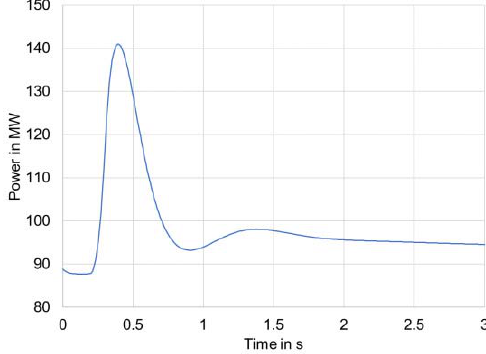
Figure 9. Transient response by TORT-TD/CTF of a 12.5 cm withdrawal of a partially inserted control blade (start at 0.2 s and end at 0.3 s) in the lower axial section of one assembly in the 4-by-4 mini core